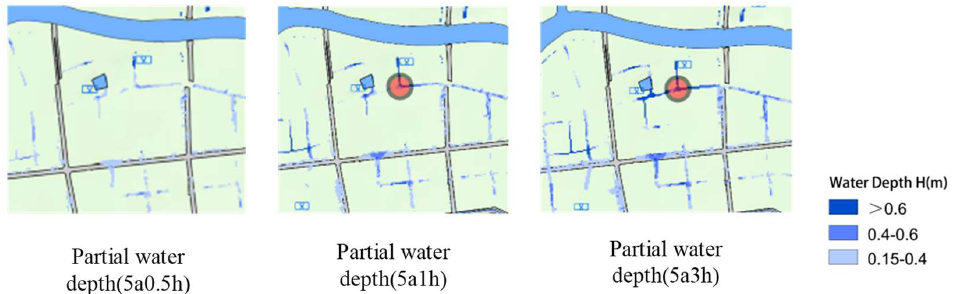
Figure 8. Water depth map for 1 in 5 year